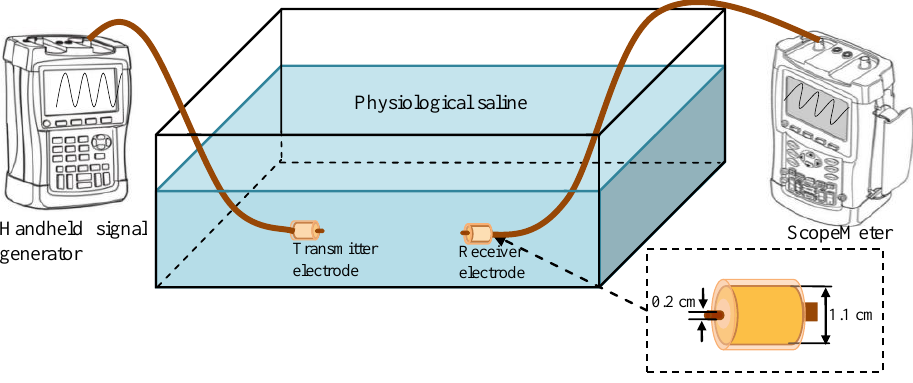
Figure 6. Measurement setup of implant IBC based on capacitive